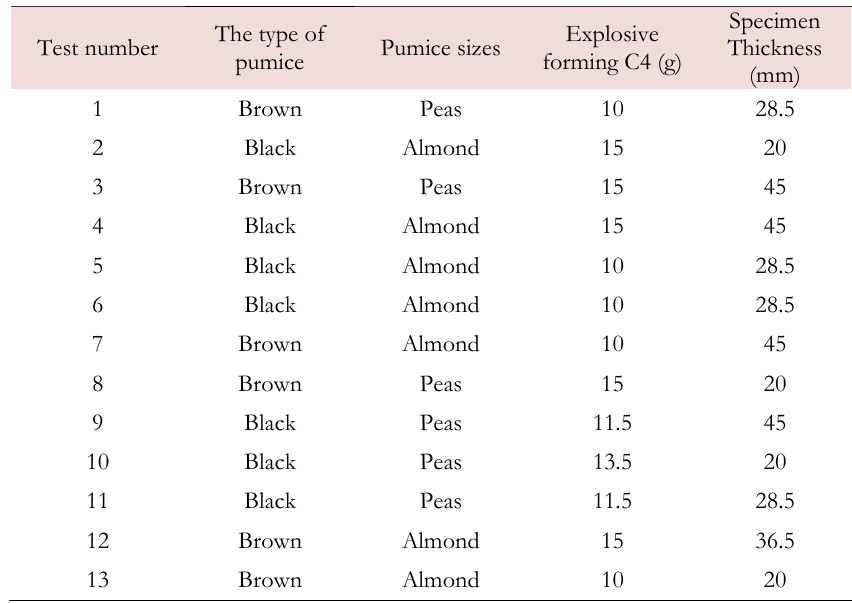
Table 14: Suggested experiments response surface